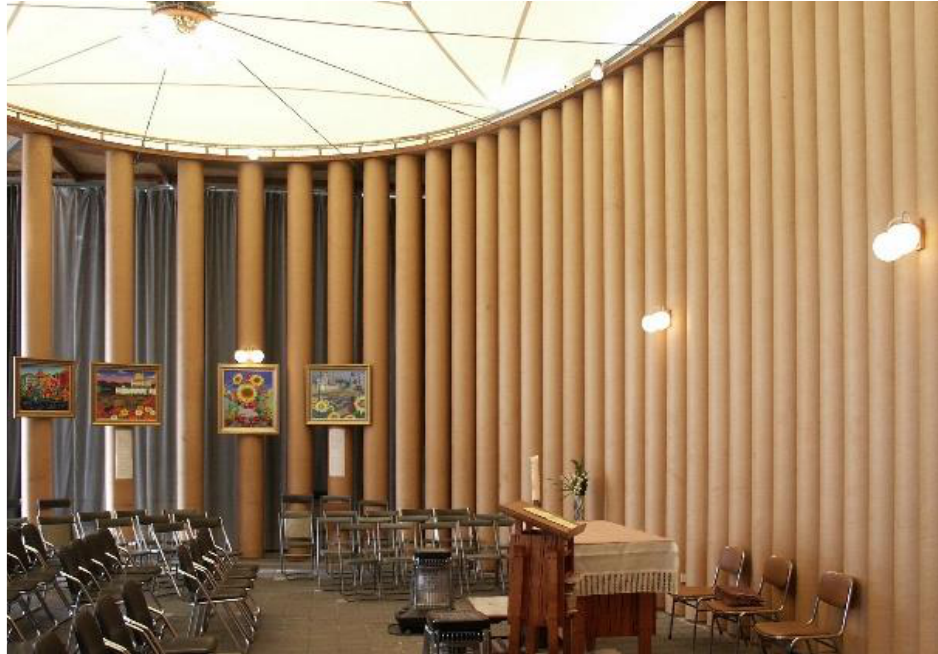
Figure 5. Use of cardboard as tube in construction (Takatori Catholic Church [64]).